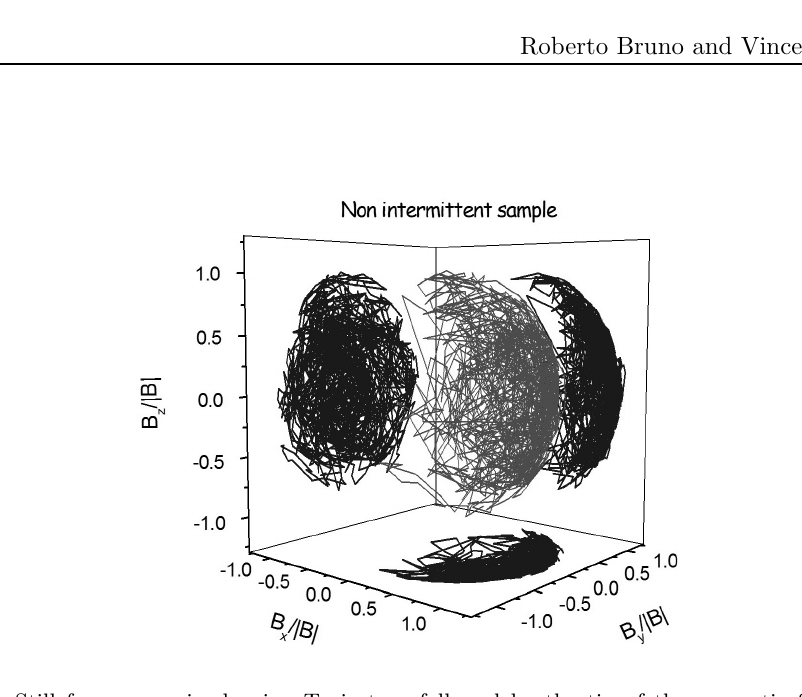
Figure 99: Still from a movie showing Trajectory followed by the tip of the magnetic field vector in the minimum variance reference system during a time interval not characterized by intermittency. The duration of the interval is 2000 (cid:214) 6 s but the magnetic field vector moves only for 100 (cid:214) 6 s in order to make a smaller file (movie kindly provided by A. Vecchio). (To watch the movie, please go to the online version of this review article at http://www.livingreviews.org/lrsp-2013-2 .)